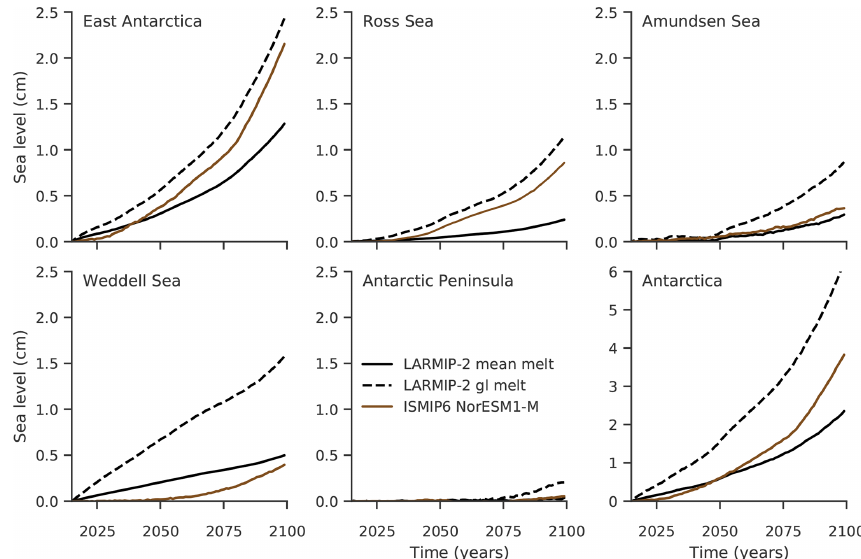
Figure 6. Projections using PICO forced with NorESM1-M ocean conditions compared to projection obtained by the response function. The response function is derived for the INIT configuration. It is applied to the basal melt rate forcing from PICO using average conditions underneath the shelves in the corresponding sector (generally an underestimation) and using the melting at the grounding line (generally an overestimation) from Fig. 4.